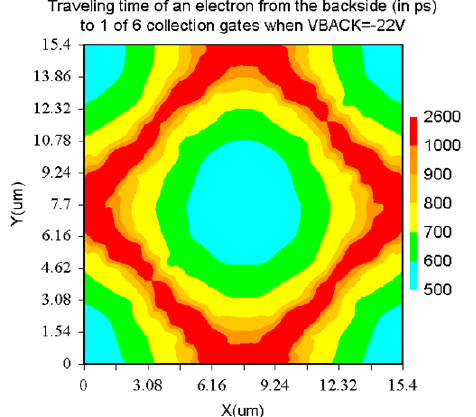
Figure 16. Traveling time of an electron from a point of the backside to 1 of 6 collection gates (ps) (Backside voltage −22